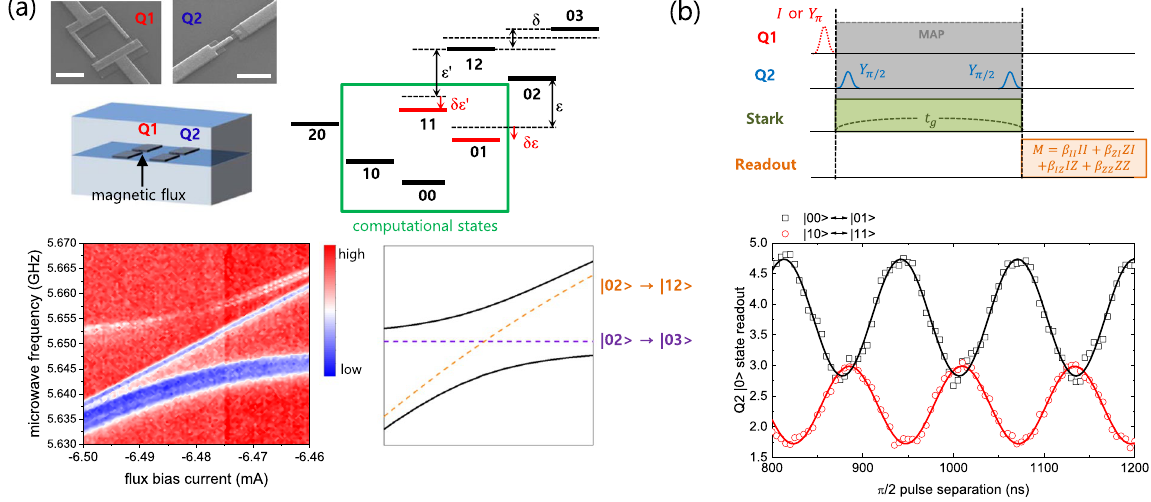
Figure 1. ( a ) Top left: Scanning electron microscope image of two qubits (scale bar is 1 μ m) with schematic diagram of the three dimensional circuit QED system configuration. Top right: Energy diagram of the two-qubit system. Four states inside the green solid box compose the computational states. The states |12 〉 and |03 〉 are tuned in situ by adjusting the magnetic flux bias through Q1. Bottom Left: The experimental result of three- tone microwave spectroscopy. The color plot shows the |02 〉 population. |12 〉 and |03 〉 states are aligned at the current bias value of − 6.48 mA. Bottom right: Schematic representation of transitions induced by three-tone microwave spectroscopy. Orange (purple) dashed line corresponds to the transition from |02 〉 to |12 〉 (from |02 〉 to |03 〉 ). Due to the avoided crossing of two transitions, solid black lines are observed in the experiment. The straight line in between appears due to the transition from |00 〉 to |10 〉 and from |01 〉 to |11 〉 , to which the reduction of the population at |02 〉 state is attributed. ( b ) Top: Illustration of the pulse sequence of the MAP gate. With the π pulse for Q1 on (off), the Ramsey fringe between |00 〉 and |01 〉 (|10 〉 and |11 〉 ) is induced by a Stark tone. Bottom: Experimental result of the Stark tone-induced Ramsey fringe. Here the |00 〉 state population is measured for |00 〉 –|01 〉 Ramsey, and the |10 〉 state population for |10 〉 –|11 〉 Ramsey. The oscillation period is determined by the amount of the shift δε for the state |01 〉 ( δε ′ for |11 〉 ) as shown in ( a ). At t g = 1070 ns, two traces are completely